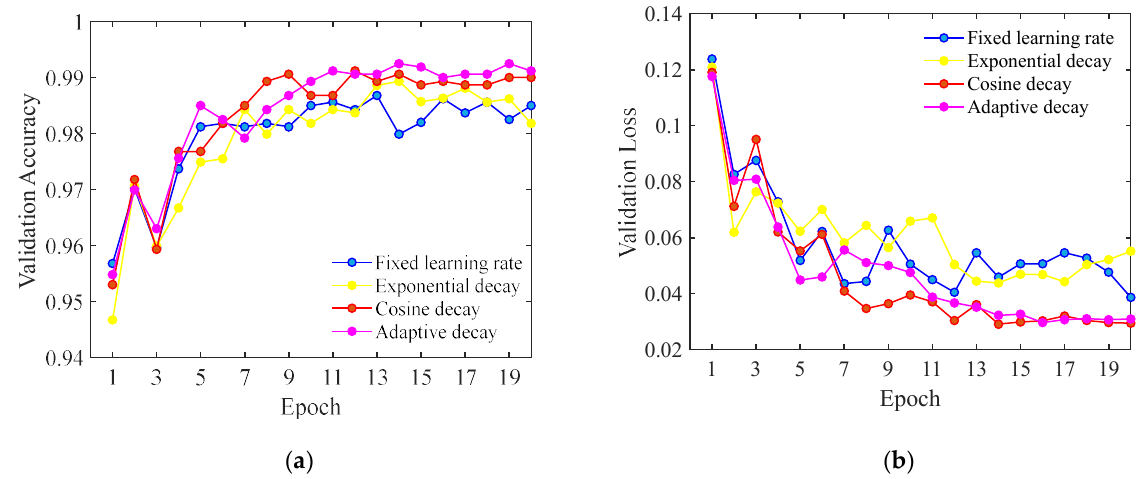
Figure 7. The validation ( a ) accuracies and ( b ) losses of the cases with different learning